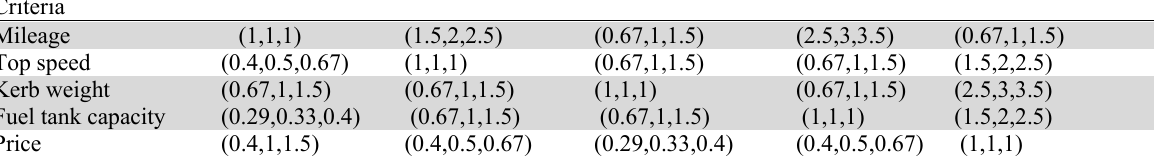
Pairwise comparison matrix